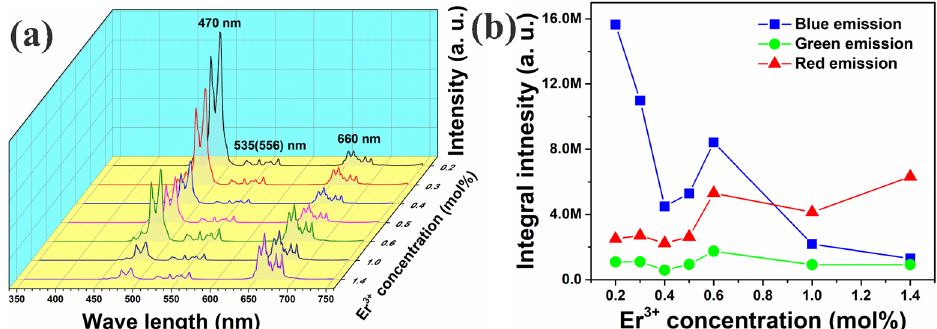
Figure 4. ( a ) UC emission spectra generated for Y 2 O 3 -ZnO:Yb 3+ /Er 3+ /Tm 3+ -tridoped nano-phosphors excited using 980 nm laser diode operated at 1.0-W pump power. ( b ) Blue, green, and red peak intensities of UC spectra plotted as functions of Er 3+ concentration.